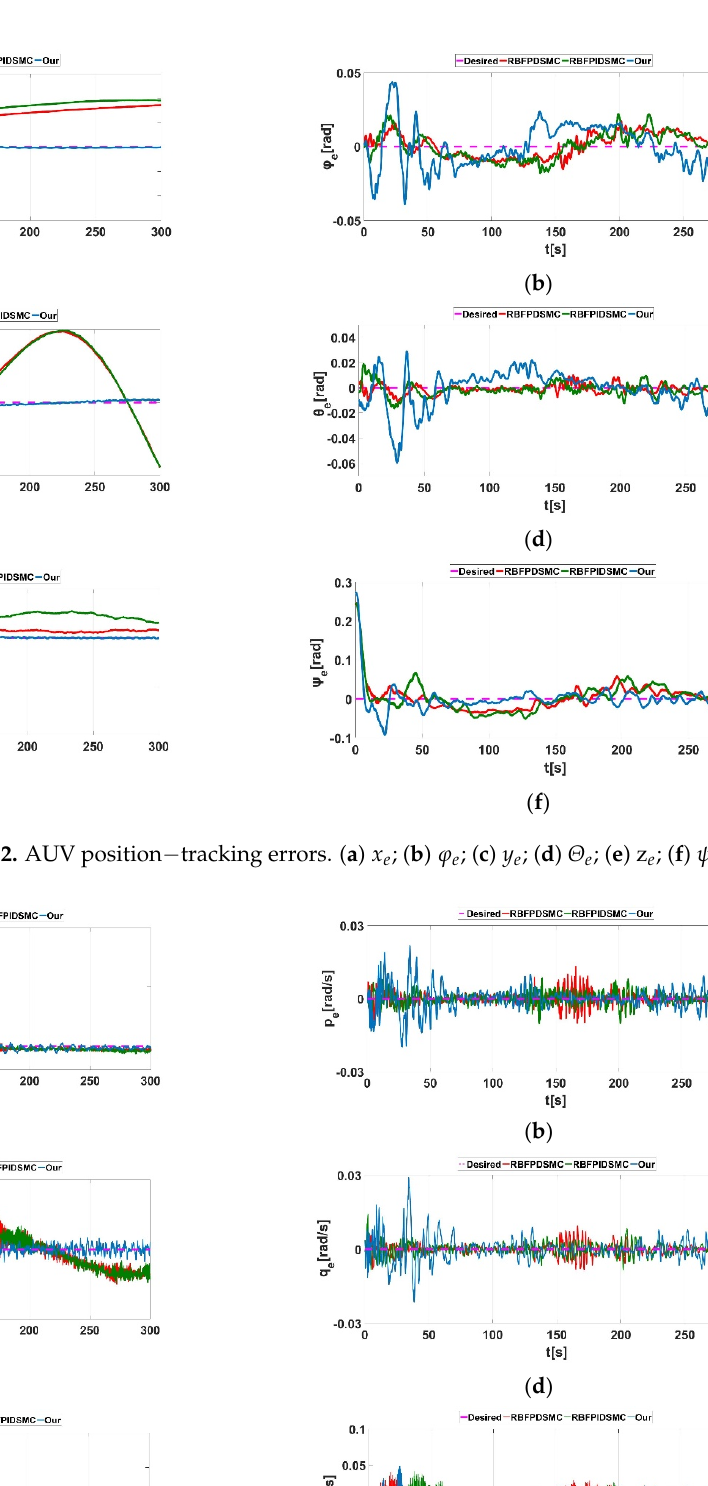
Figure 11. Three − dimensional view of the trajectory.